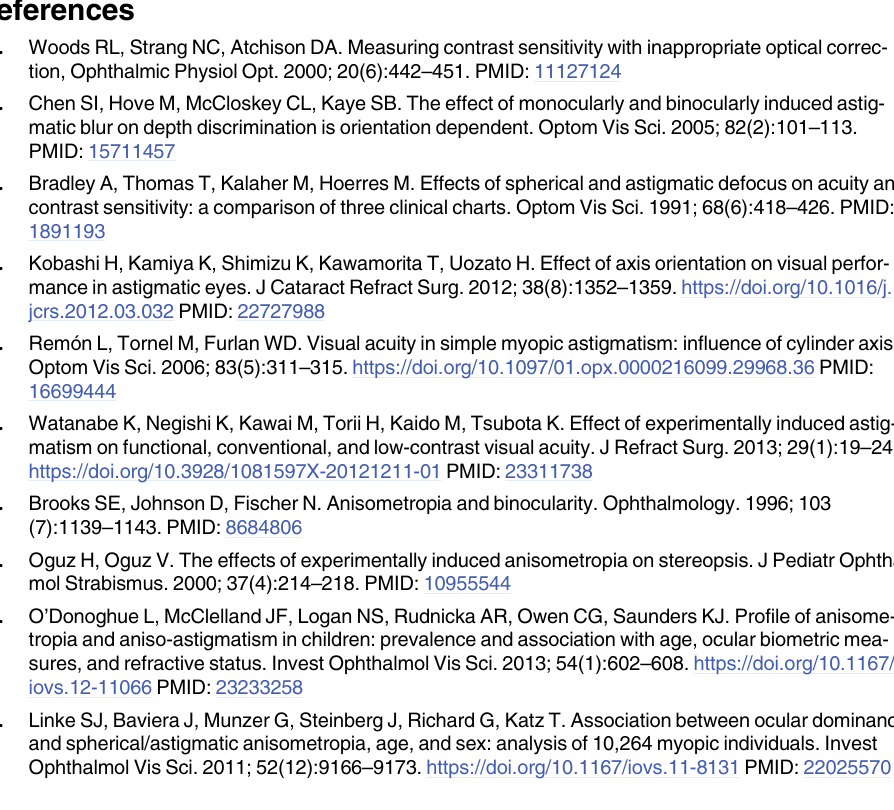
S2 Table. Minimal dataset for astigmatism and contrast sensitivity. (ATR = against-the- rule, WTR = with-the-rule, AULCSF = area under the log contrast sensitivity